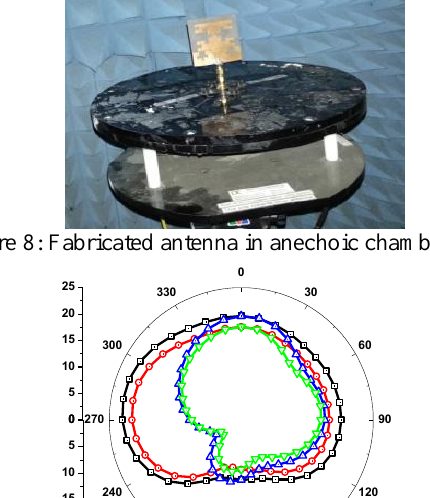
Simulated E-Plane at 2.6 GHz Measured E-Plane at 2.6 GHz